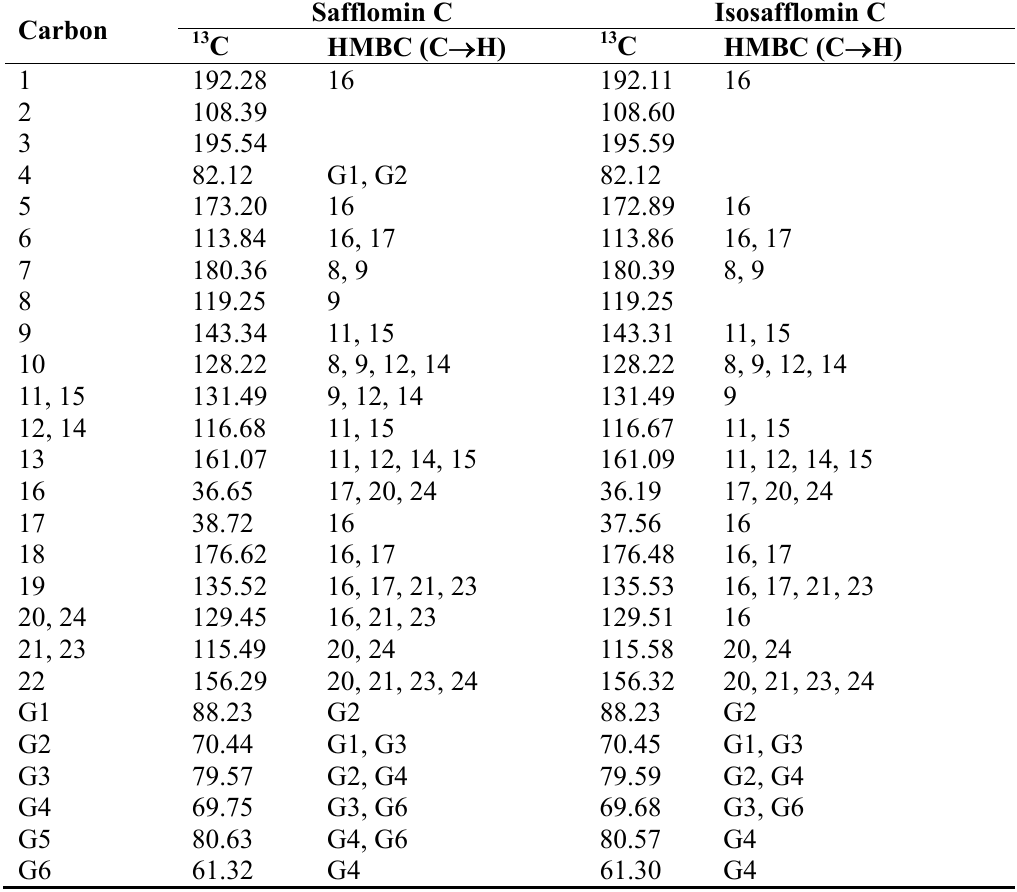
Table 12. 13 C-NMR and HMBC data of safflomin C and isosafflomin C (100 MHz, in CD